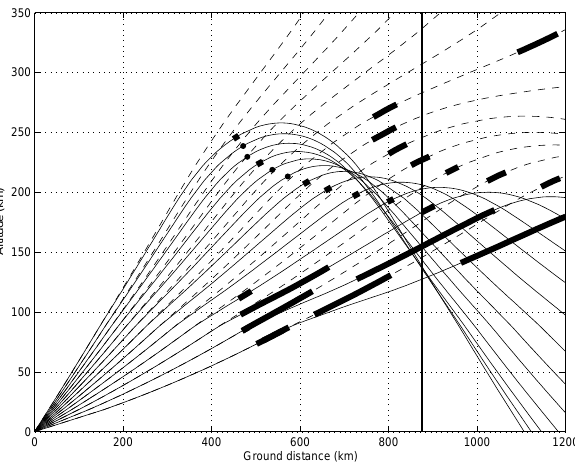
Fig. 1. The paths of HF rays transmitted from the Hankasalmi radar through the heated volume. Frequencies of 12.4 (solid lines) and 19.5MHz (dashed lines) are shown for a range of elevation angles between 6 ◦ and 30 ◦ in steps of 2 ◦ . The regions where the rays lie within 1 ◦ of orthogonality to the magnetic field line are marked by heavy lines. These regions are only marked for group ranges corresponding to the field-of-view of the CUTLASS radar used in the present experiment ( ∼ 480–1590km). The vertical line marks the ground distance of the Tromsø heater from the